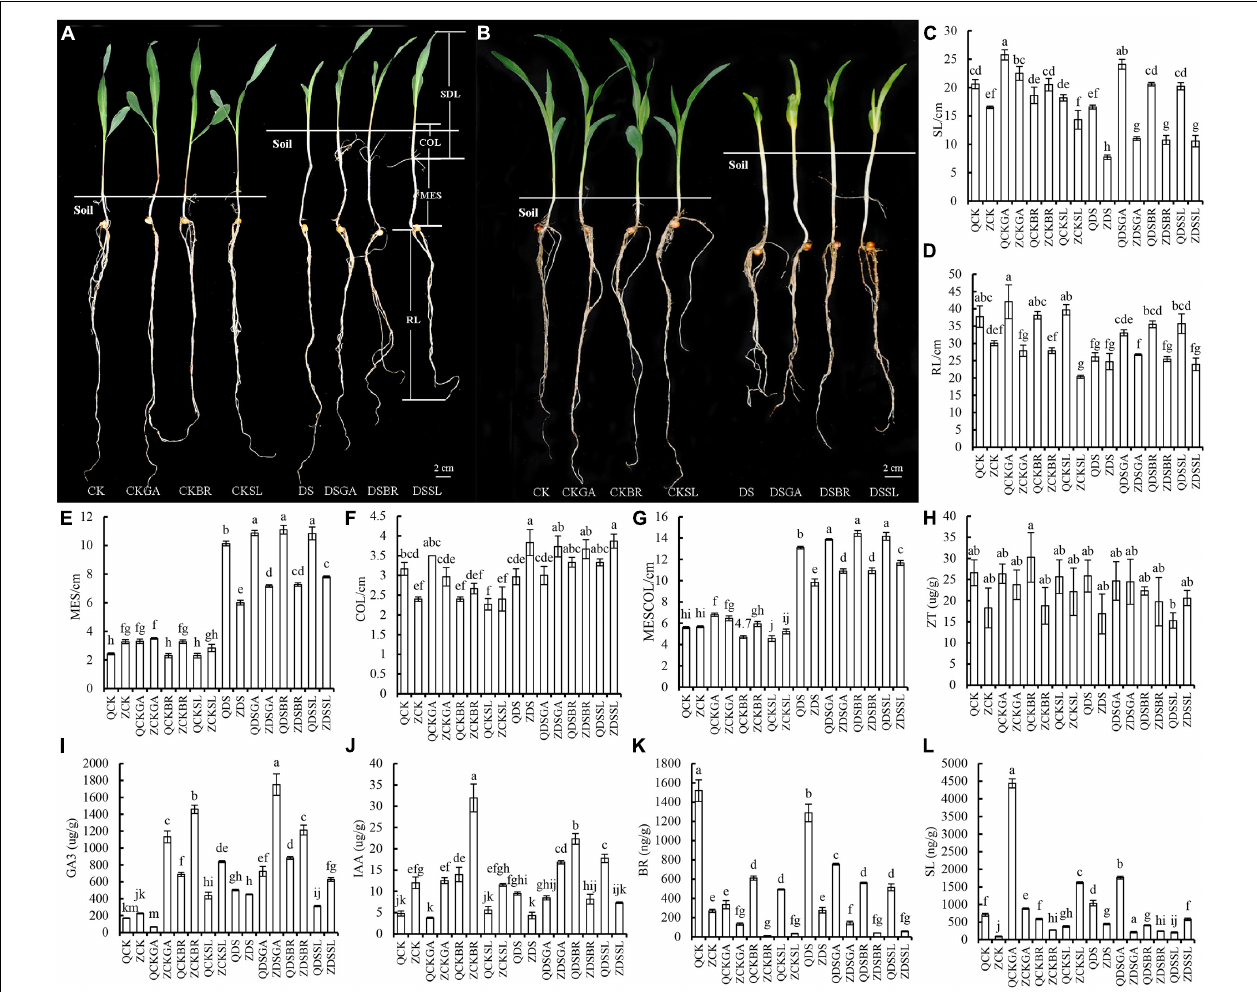
FIGURE 1 | Changes of morphology and endogenous hormone levels of maize inbred lines treated with exogenous hormones. Morphology of (A) Qi319 and (B) Zi330 under different treatments. (C–L) Phenotypic indexes and endogenous hormones contents in the mesocotyl under different treatments. CK, normal sowing; CKGA, after treatment with exogenous GA 3 under normal sowing; CKBR, after treatment with exogenous BR under normal sowing; CKSL, after treatment with exogenous SL under normal sowing; DS, deep sowing stress; DSGA, after treatment with exogenous GA 3 under deep sowing; DSBR, after treatment with exogenous BR under deep sowing; DSSL, after treatment with exogenous SL under deep sowing; Q, Qi319; Z, Zi330; MES, Mesocotyl length; COL, coleoptile length; MESCOL, the sum of mesocotyl and coleoptile; SDL, seedling length; RL, root length.